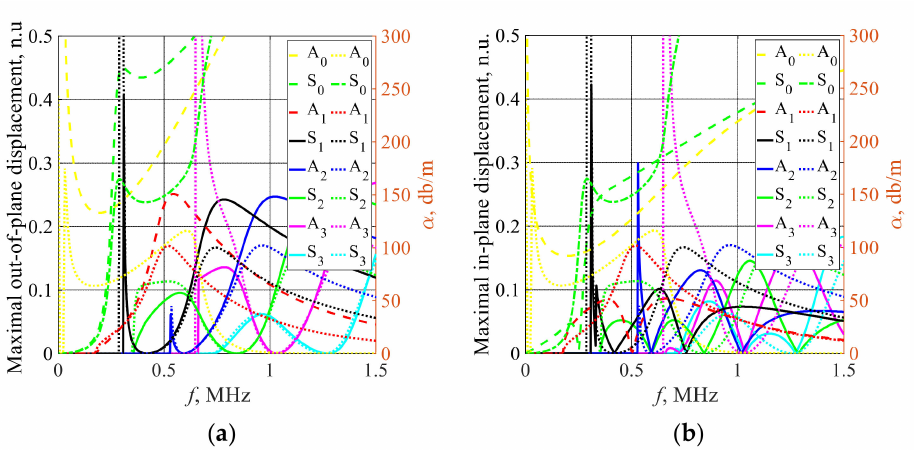
Figure 3. Comparison of displacement on surface (dashed and solid lines) and leakage losses (dash- dot and dotted lines): ( a ) out-of-plane component displacement and leakage losses versus frequency; ( b ) in-plane component amplitude and leakage losses vs. frequency. The indices next to the mode shapes in the legend denote mode